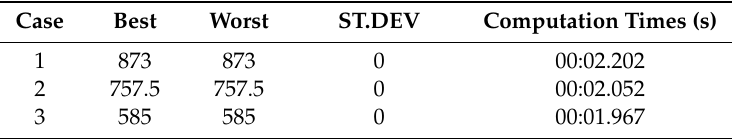
Table 2. Parameter verification test results of genetic algorithm.